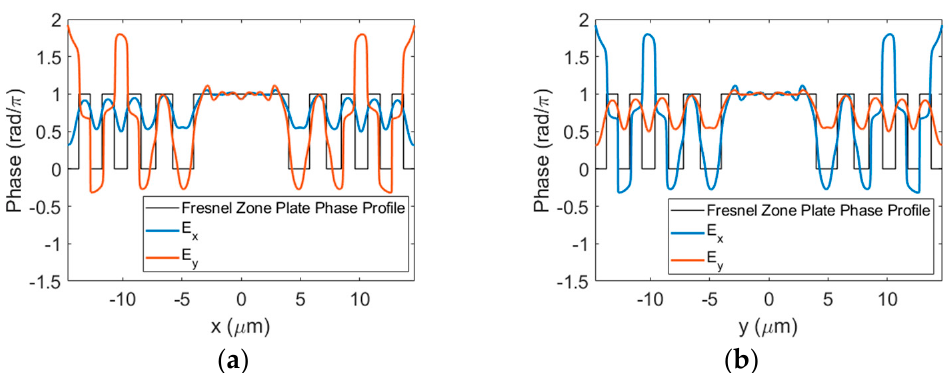
Figure 6. Cross-sections of the near- fi eld phase along the ( a ) horizontal and ( b ) vertical axes through the center of the BPFZP zone plate.